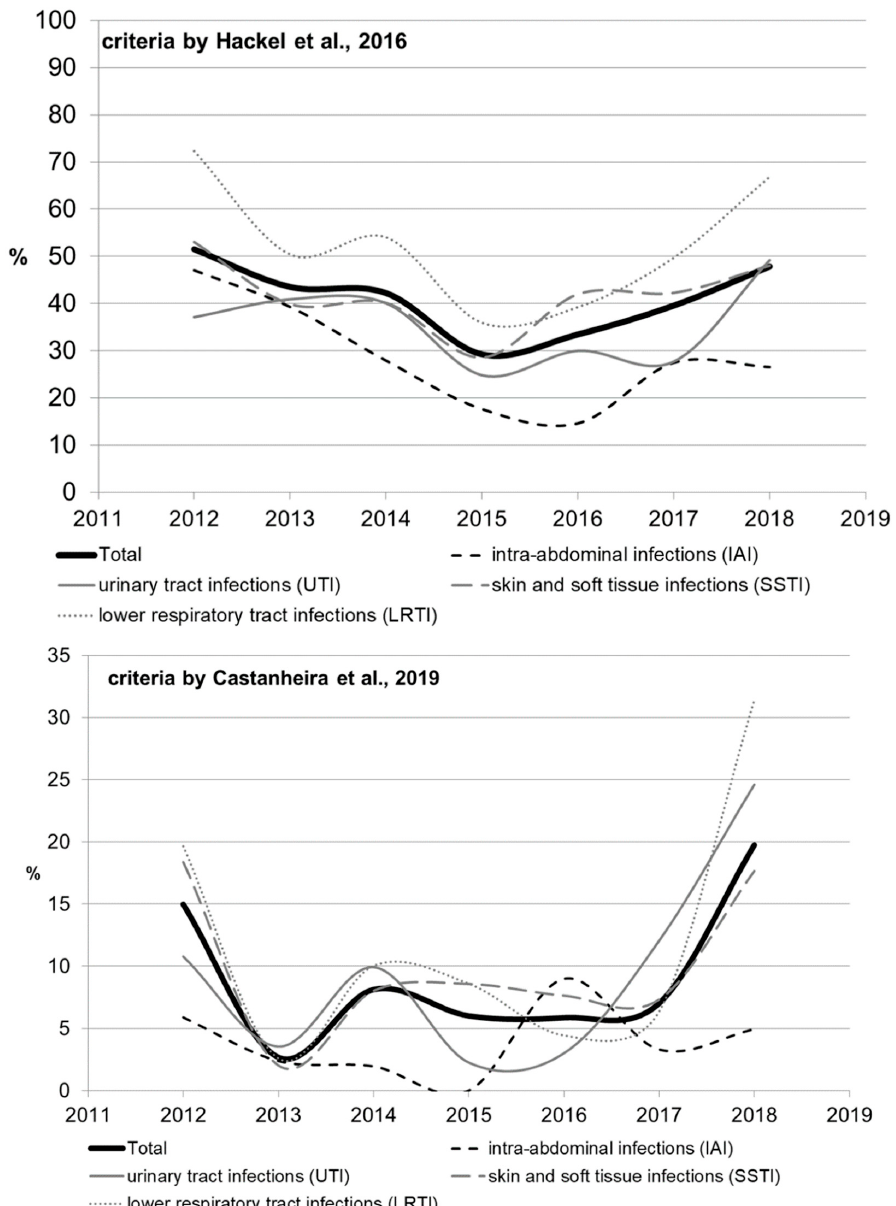
Figure 3. The dynamics of the percentage of multidrug-resistant strains among all Enterobacterales isolates depending on location of the infection source.